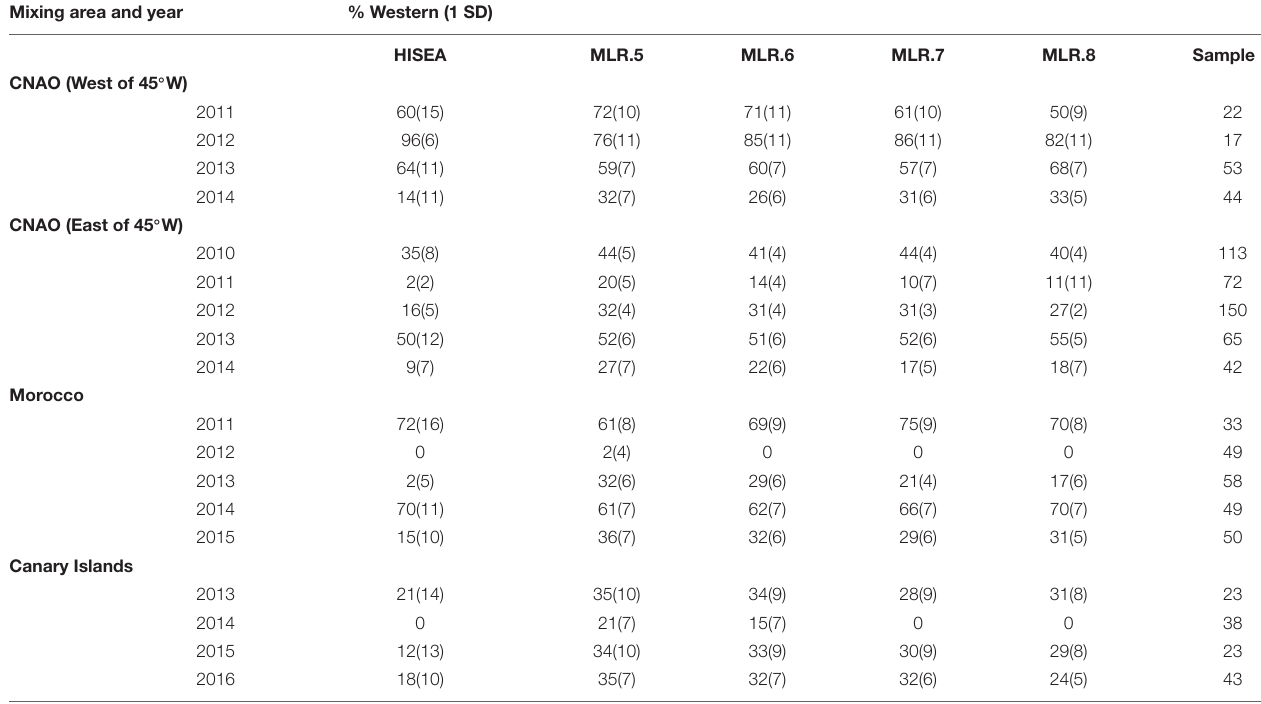
TABLE 1 | Estimated proportion of “western migrants” detected in samples of Atlantic bluefin tuna from HISEA and multinomial logistic regression (MLR) models. Mixing area and year % Western (1 SD) HISEA MLR.5 MLR.6 MLR.7 MLR.8 Sample N CNAO (West of 45 ◦ W)